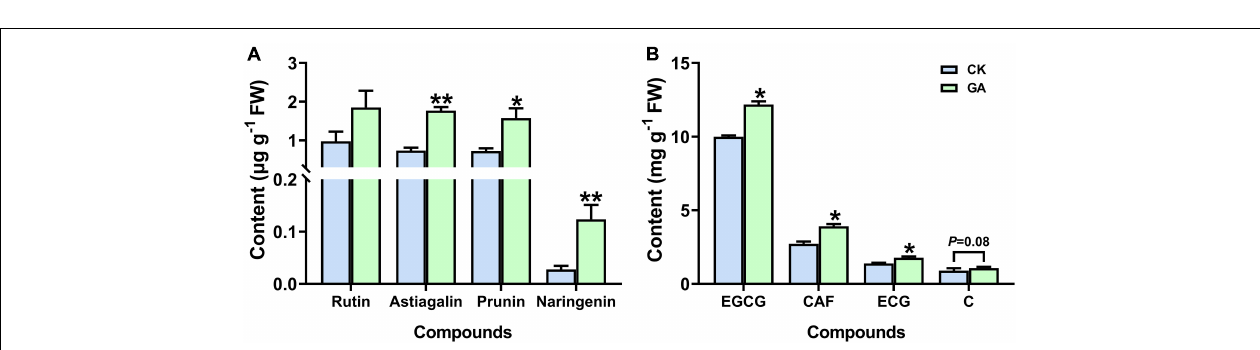
FIGURE 3 | GA treatment upregulated the expression levels of genes. Data are presented as means + SE ( n = 3), and the asterisk indicates significant differences between GA treatment and CK (* P < 0.05, ** P < 0.01, Student’s t -test).